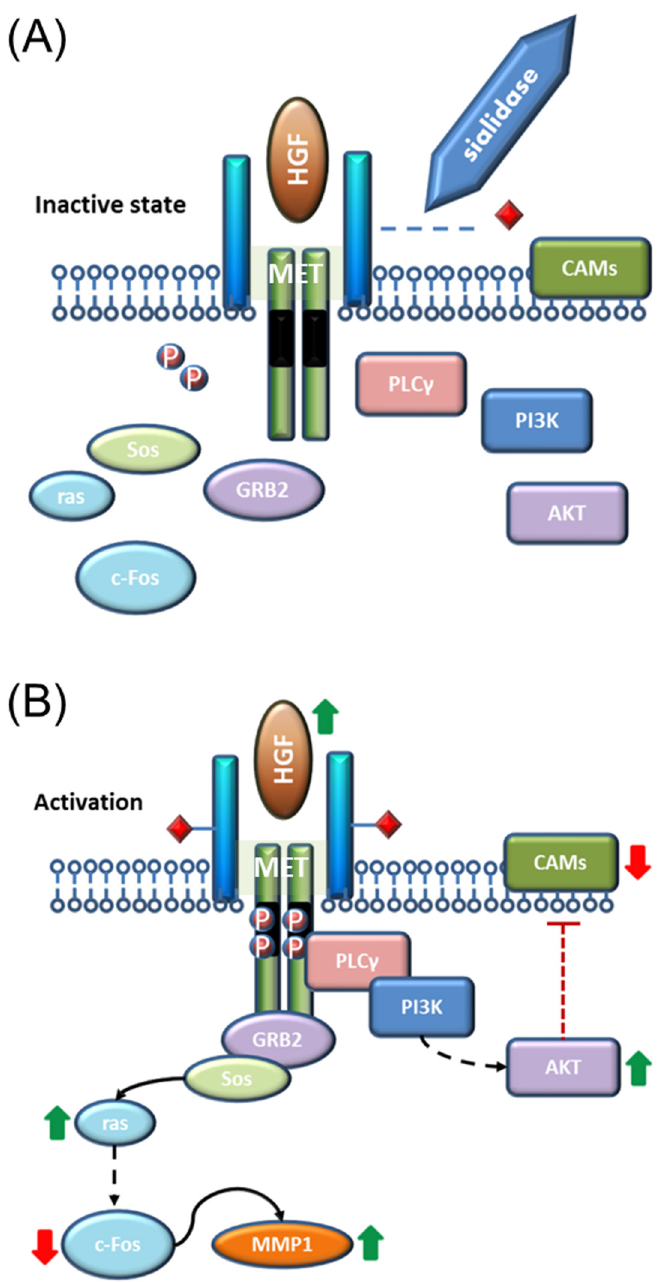
Fig 6. Proposed mechanism of MET sialylation affecting the activation of signaling cascades to disrupt anchorage-dependence. Diagrams are simplified based on known mechanisms. (A) Hyposialyation leads to diminished response of the receptor and thus no pathway activation. (B) Sufficient sialylation on MET allows activation by its ligand, HGF, causing up-regulation of MMP1 and down-regulation of cell adhesion